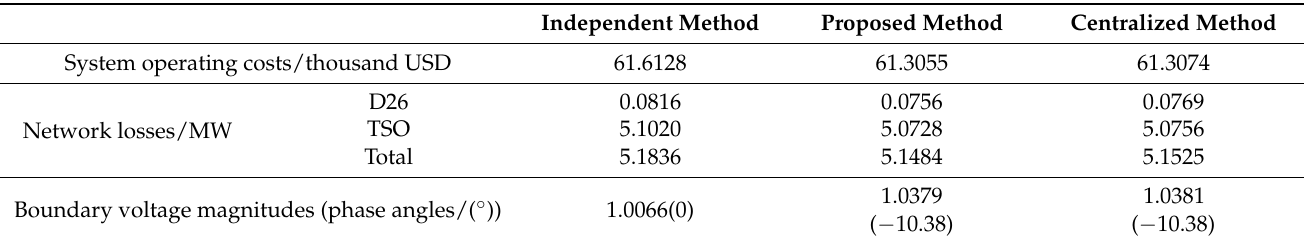
Table 2. Comparison of the results of solving test case 1 by different